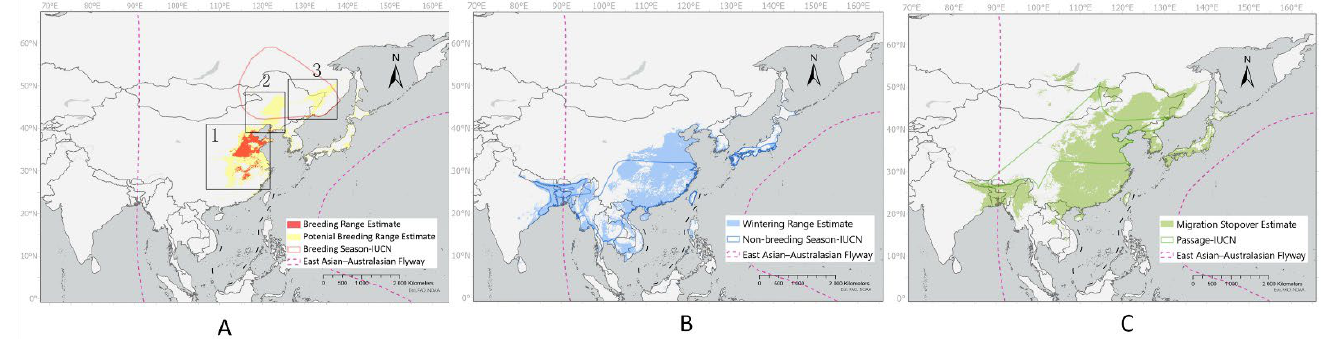
Figure 4. Maps showing the breeding distribution range of Baer’s Pochard in the recent two decades is in central-east China ( A ); the wintering ground has been shifting north and expended ( B ); and migratory stopovers overlaps with both breed and wintering distribution ( C ).